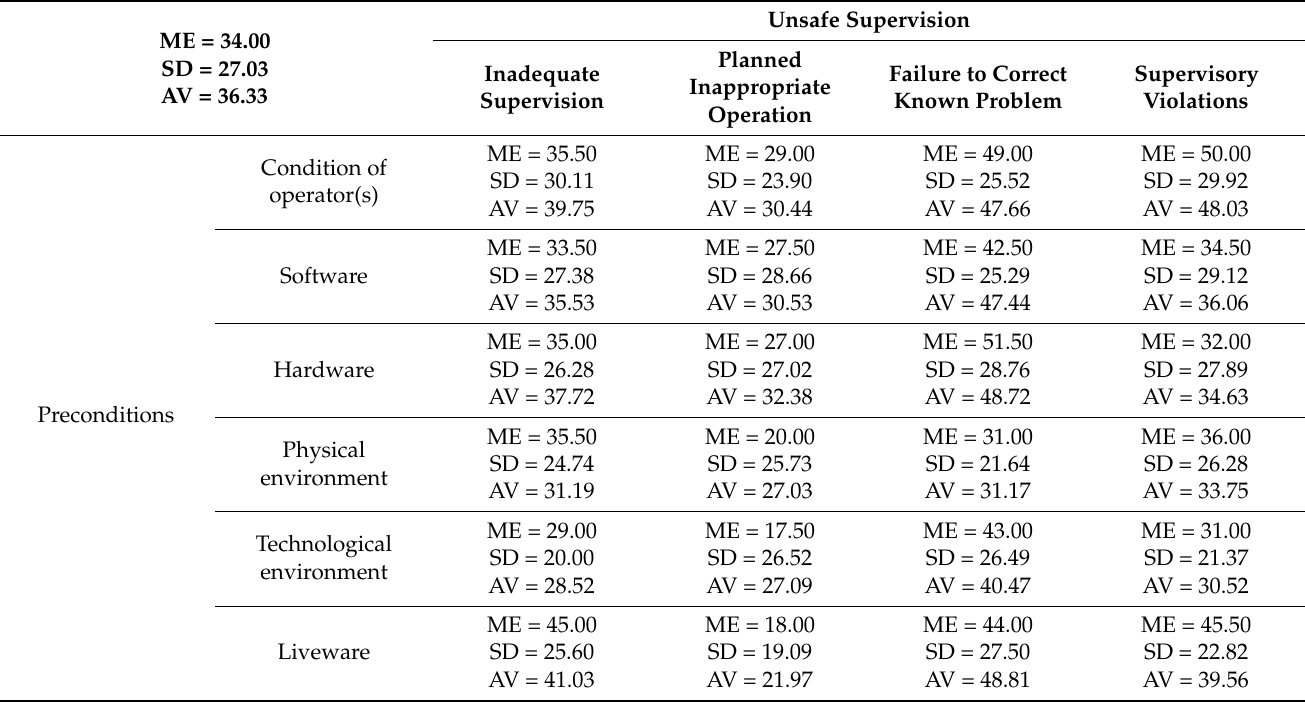
Table A3. Median (ME), standard deviation (SD), and average (AV) for responses on Stage 3 (how Unsafe supervision affects the occurrence of Preconditions).